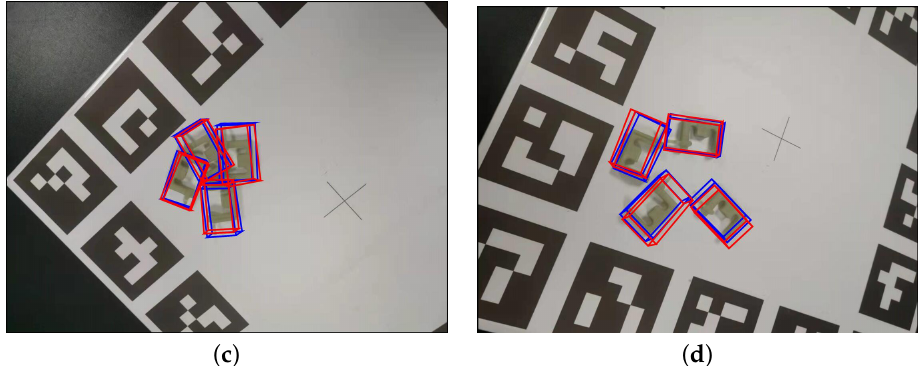
Figure 5. Some qualitative results of our proposed method. The bounding boxes in blue denote the ground-truth poses of the antenna support, while the bounding boxes in red denote the poses estimated using our method. ( a – d ) are examples that random selected from the test dataset to show the effectiveness of our proposed method. The pictures are captured from different view